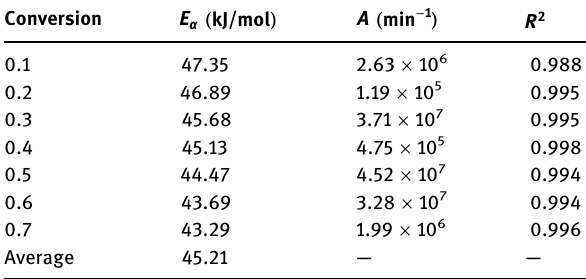
Table 5: Combustion kinetic parameters of sample